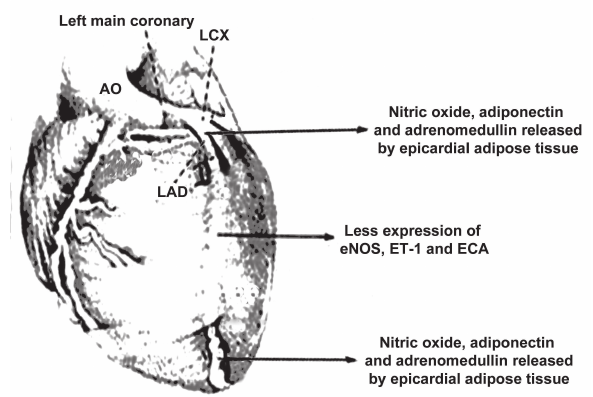
Fig. 3 – Major pharmacological aspects